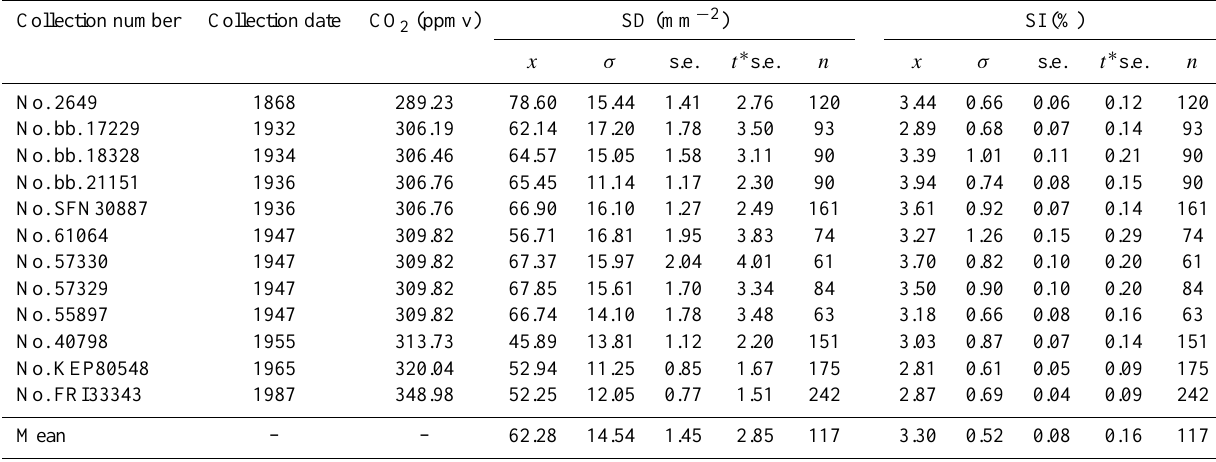
Table 2. Summary of stomatal parameters of the adaxial surface from modern Nageia motleyi (Parl.) De Laub. Collection number